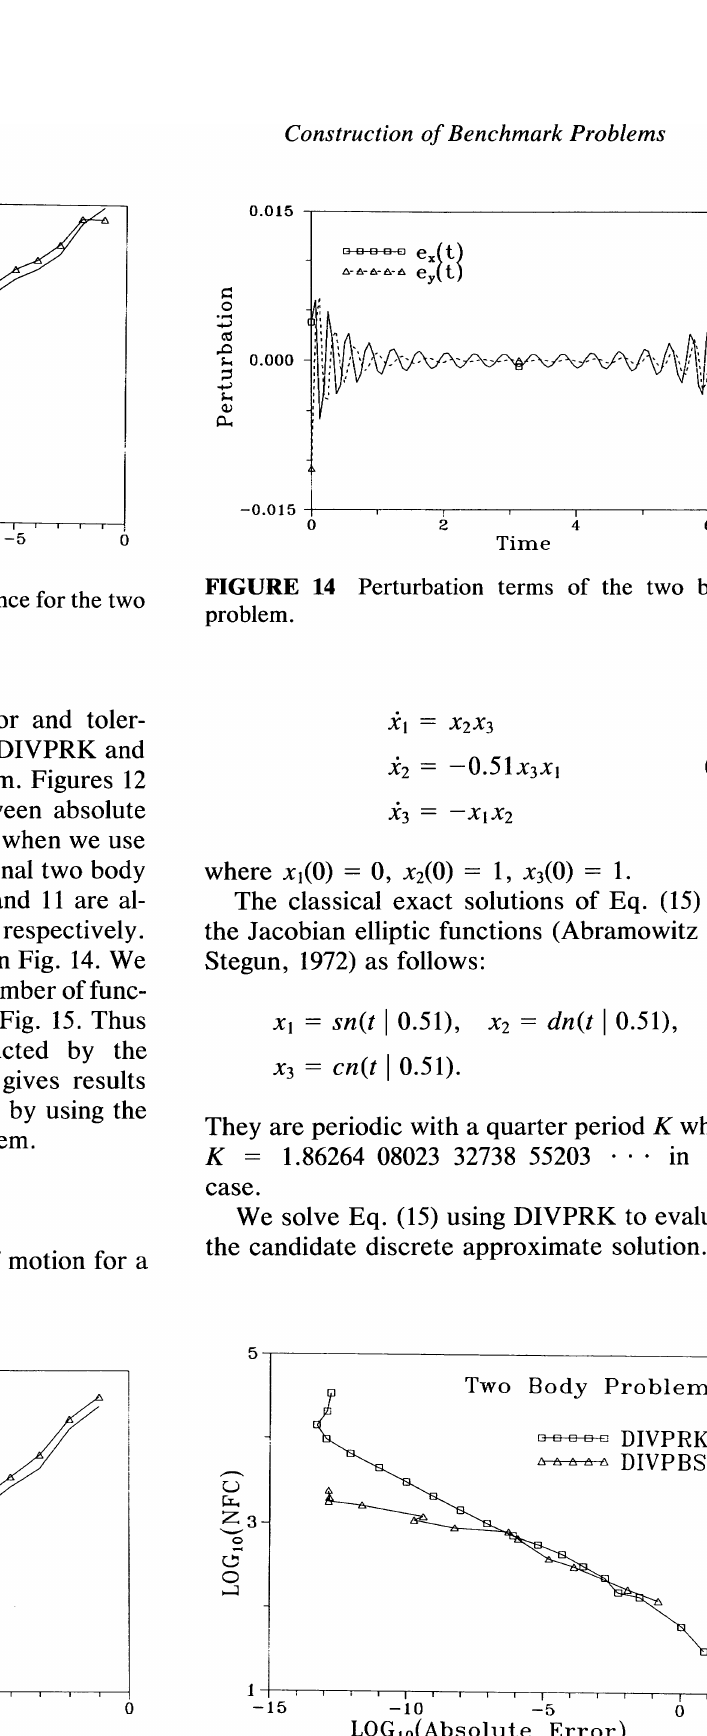
FIGURE 13 Absolute error vs. tolerance for the two body problem (DIVPBS).